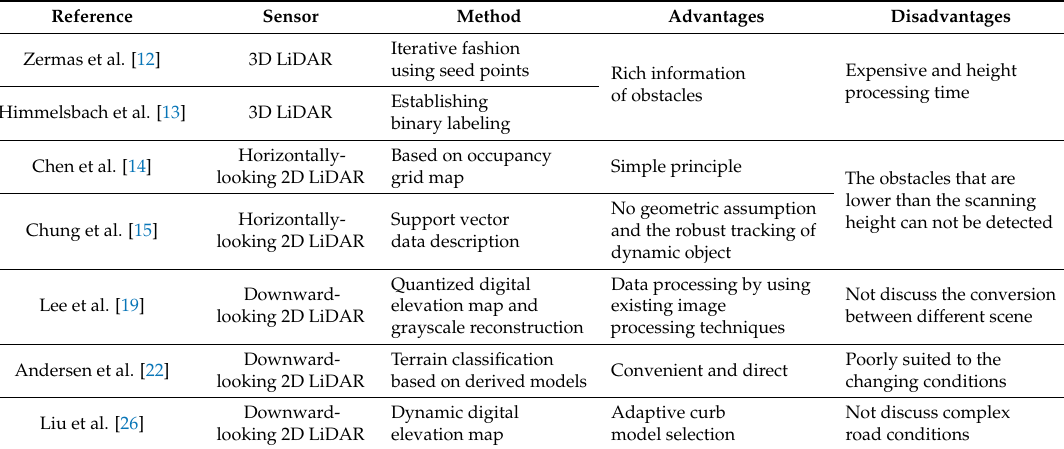
Table 1. An overview of related